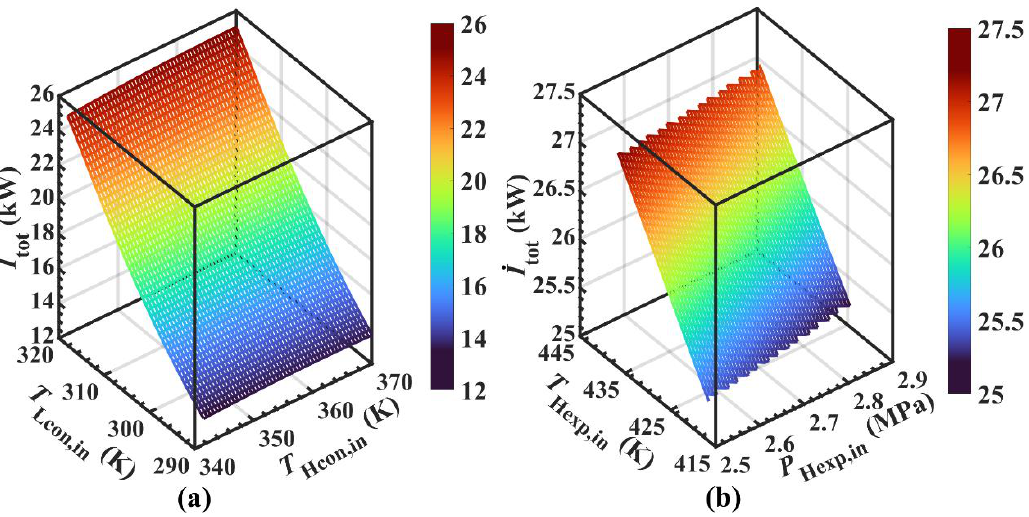
Figure 16. Influence characteristics of key variables on exergy destruction. (a) Effect characteristics of condenser inlet temperature in different cycles on exergy destruction. (b) Effect characteristics of inlet temperature and pressure of the expander of the HT cycle for system exergy destruction.